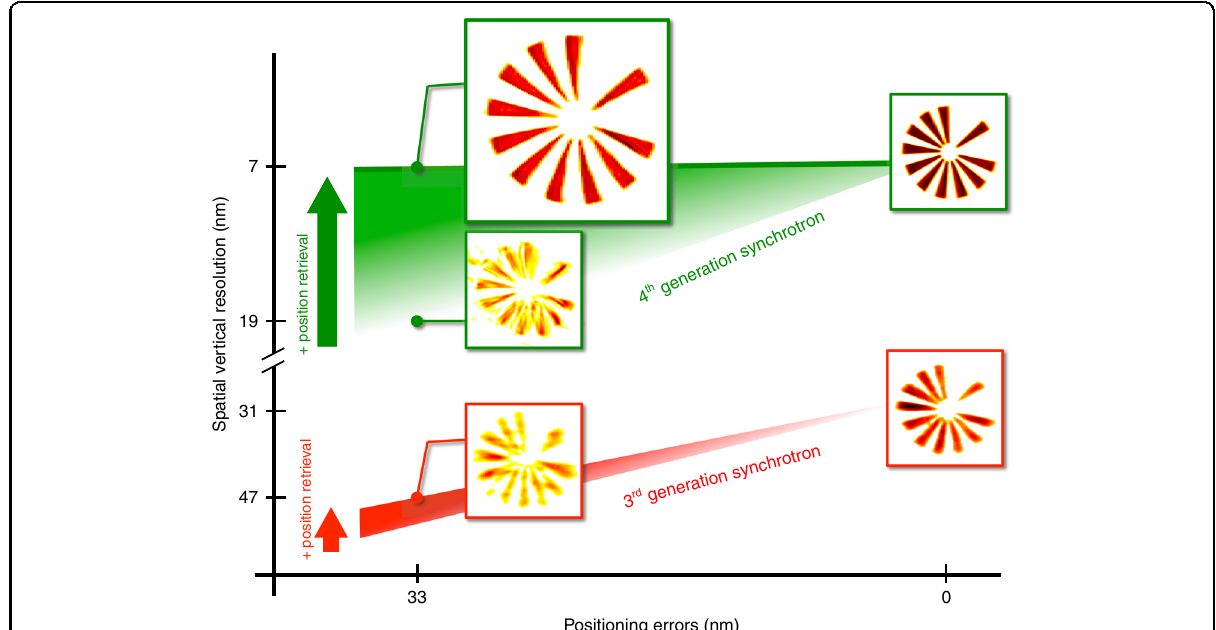
Fig. 5 Summary of the Bragg ptychography performances. The graph synthesizes the gain on the image quality (spatial resolution along the vertical direction, in nm) obtained in this study as a function of the performances of the setup (positioning errors, in nm) when one introduces a position retrieval routine in the inversion scheme. With a 3 rd -generation synchrotron source, the gain is limited and the experimental approach only performs well with a reliable sample scanner. On the contrary, with the coherent fl ux available at the 4 th -generation synchrotron source, a high (almost maximal) quality image can be retrieved even for non-perfect scanning performances. The illustrations correspond to the density distributions presented in the main text and in Supplementary